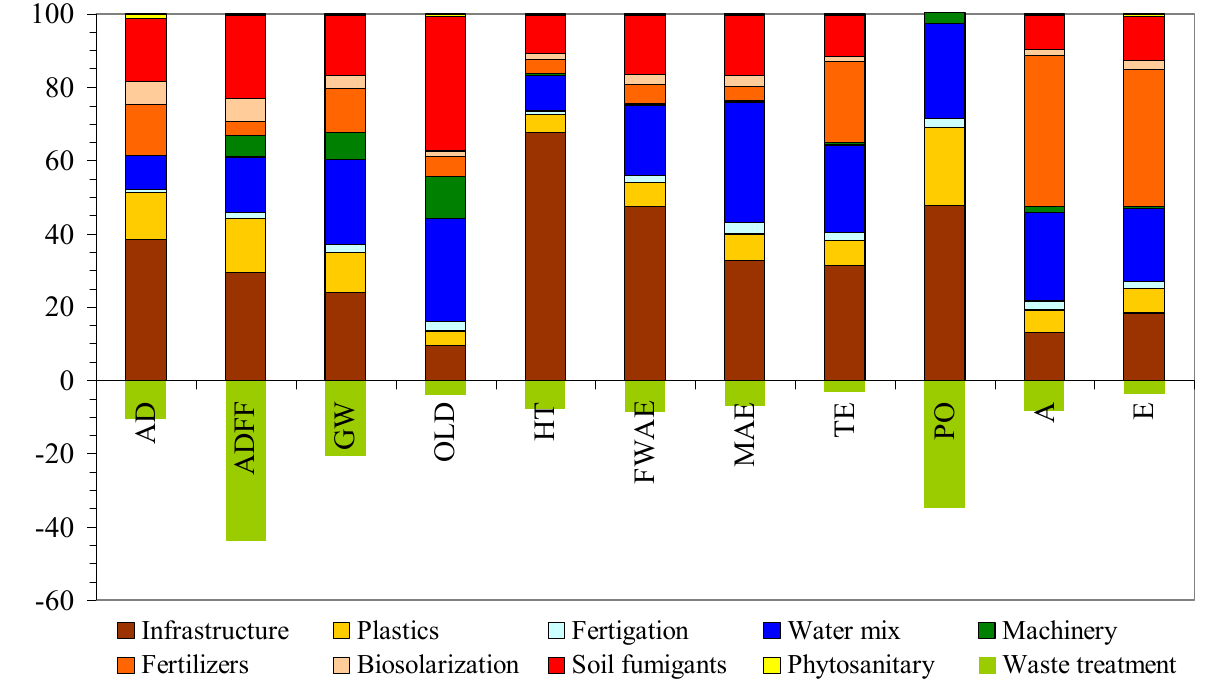
Figure 2. Contributions of the system components to each of the environmental impacts.